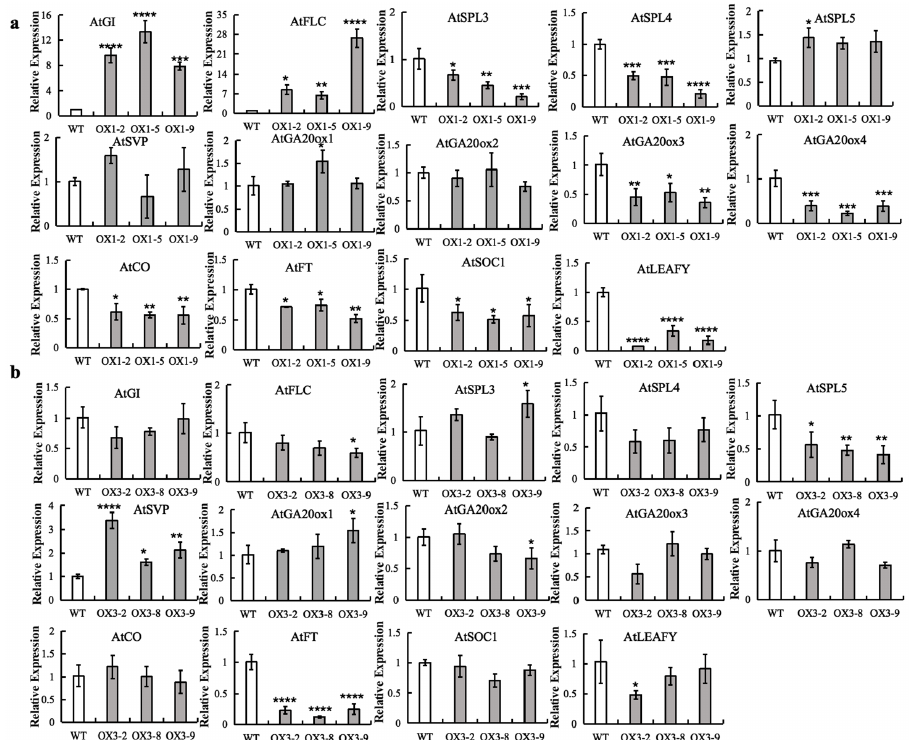
Figure 6. Transcript abundance of flowering-related genes in CiNF-YC1 - and CiNF-YC3 -overexpressing Arabidopsis . ( a ) Transcript abundance of flowering-related genes in CiNF-YC1 -overexpressing Arabidopsis under LD conditions. ( b ) Transcript abundance of flowering-related genes in CiNF- YC3 -overexpressing Arabidopsis under LD conditions. Three independent experiments were performed, and error bars indicate standard deviation. * p < 0.05, ** p < 0.01, *** p < 0.001, and **** p < 0.0001 indicate significant differences.